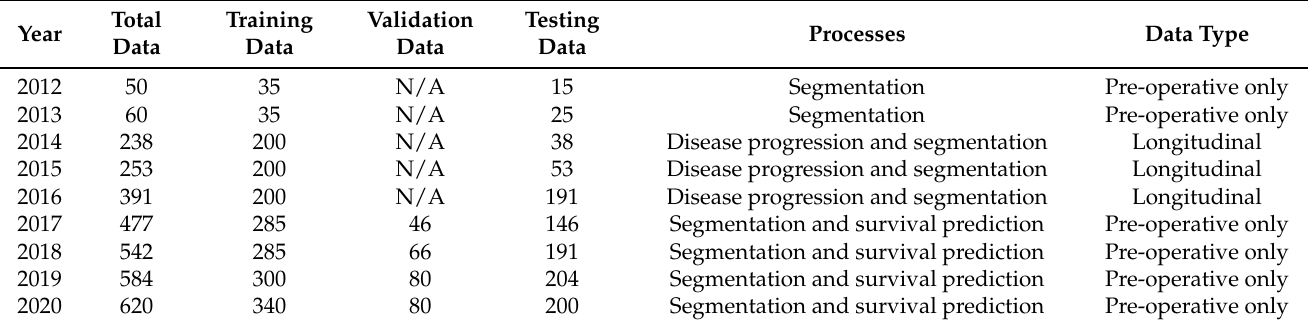
Table 2. BraTS dataset specification from 2012 to